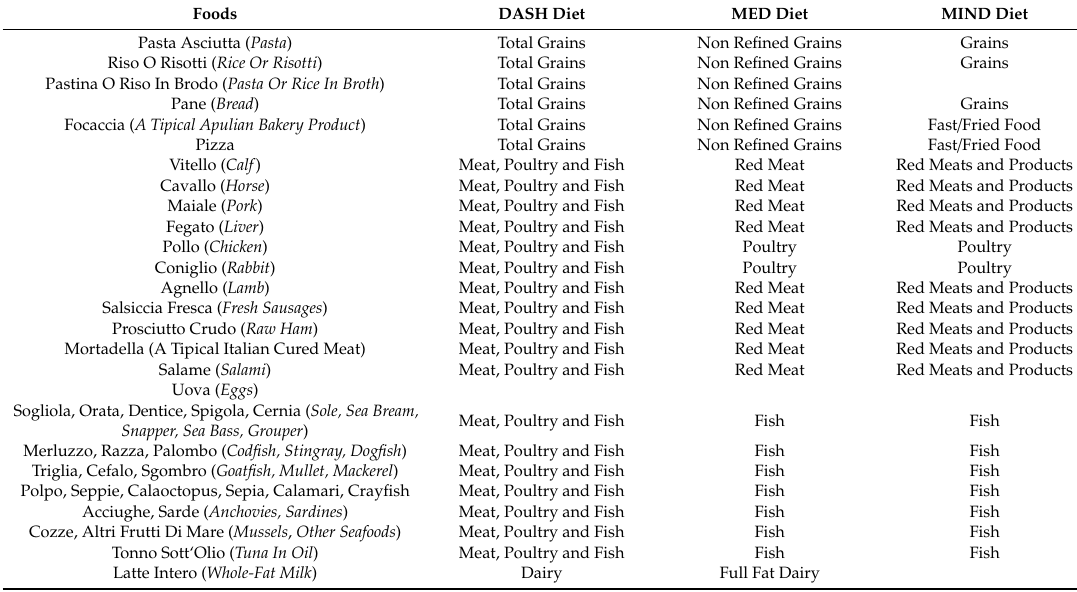
Table A2. Concordance between the single food items in the questionnaire and the healthy diet